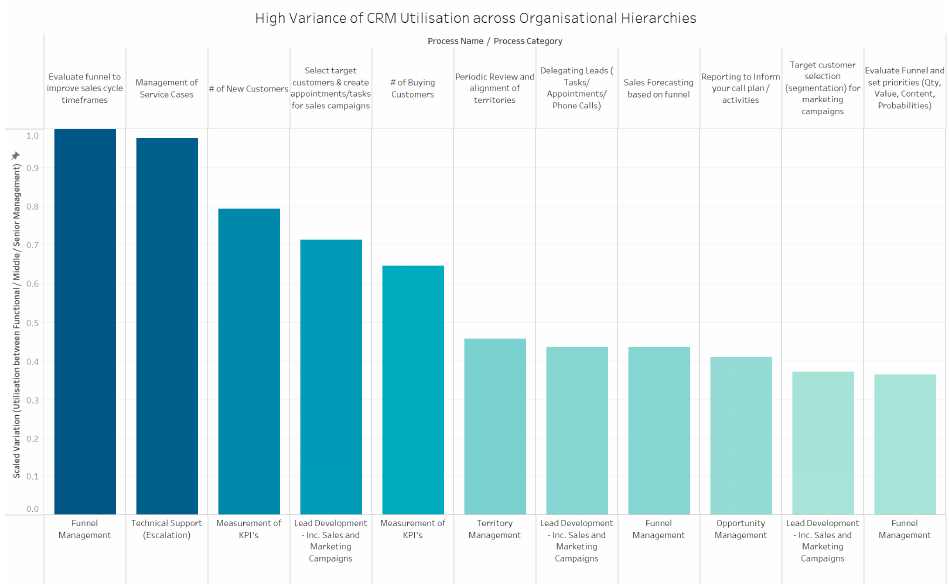
Figure 5. CRM Processes with a high variance of utilisation across organisational hierarchies, as developed for this study.